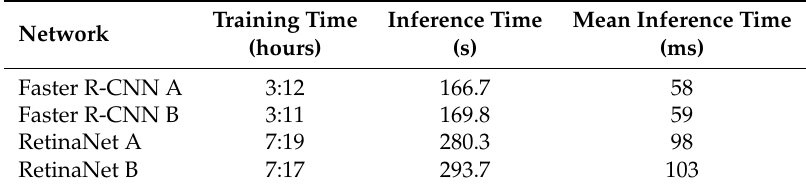
Table 4. Summary of training and inference times for configured networks. Type A networks include blurred grains, while Type B networks only include sharp